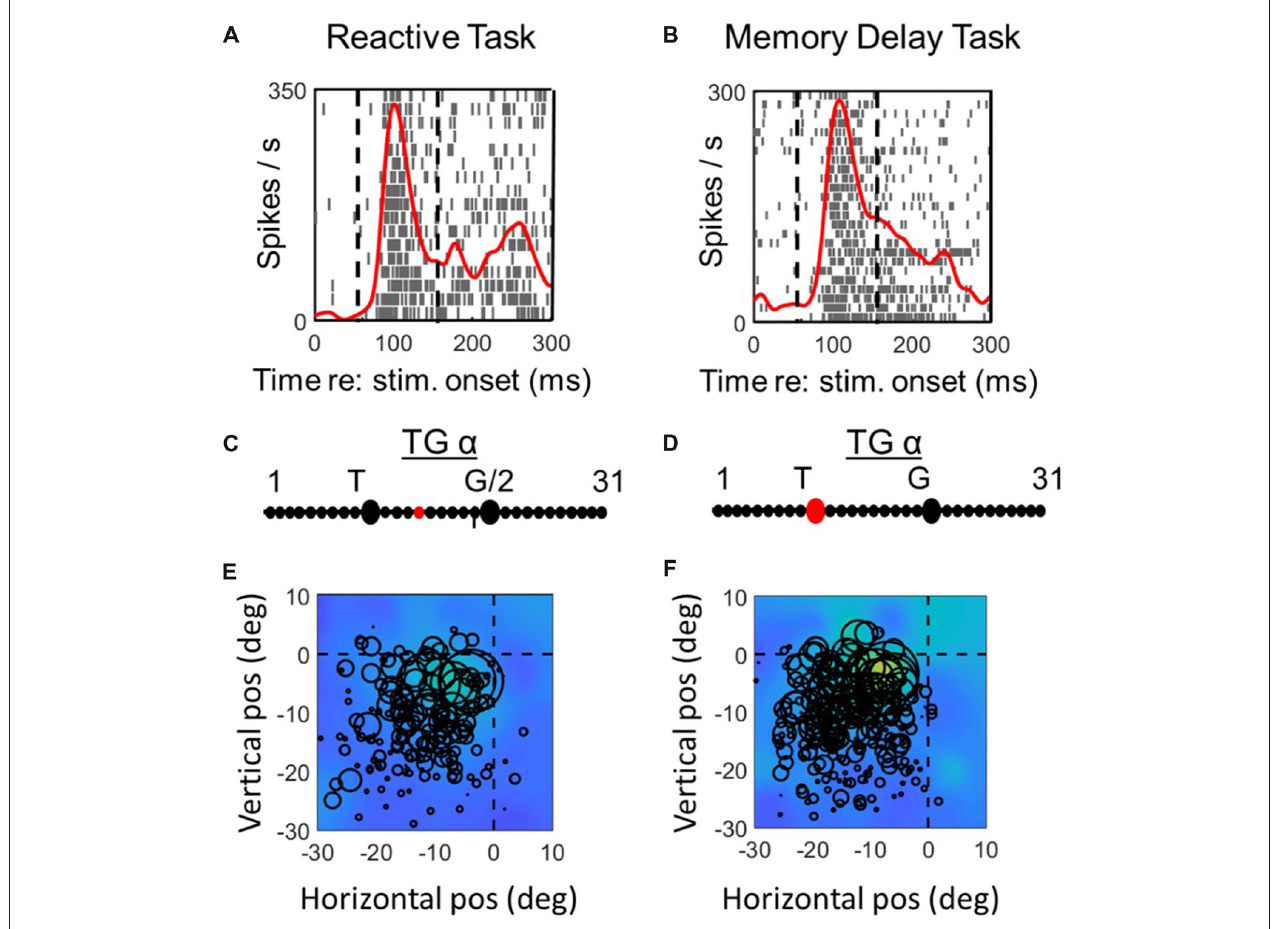
FIGURE 3 | Spatial analysis of visual activity during reactive task (left column) vs. memory delay task for one example visual neuron. Top row (A,C) : spike density and raster plot aligned with target onset. Vertical dashed lines represent the fixed window of activity which was considered in our visual analysis (60–160 ms relative to target presentation). Second row (B,D) : point of best fit (red dot) on the TG continuum for the response. Bottom row (E,F) : response fields (RFs) plotted according to the best TG fit from middle row, note that the circles represent the total number of spikes in the time window for each trial (with larger circles indicating more spikes) and the overall similarity of the circle sizes for a given point in space indicate the coherency and the quality of fit (See “Materials and Methods” section). The heat maps in the background represent the non-parametric RF fits made to these data. Thus, lighter colors/larger circles indicate the “hot spots” of the receptive